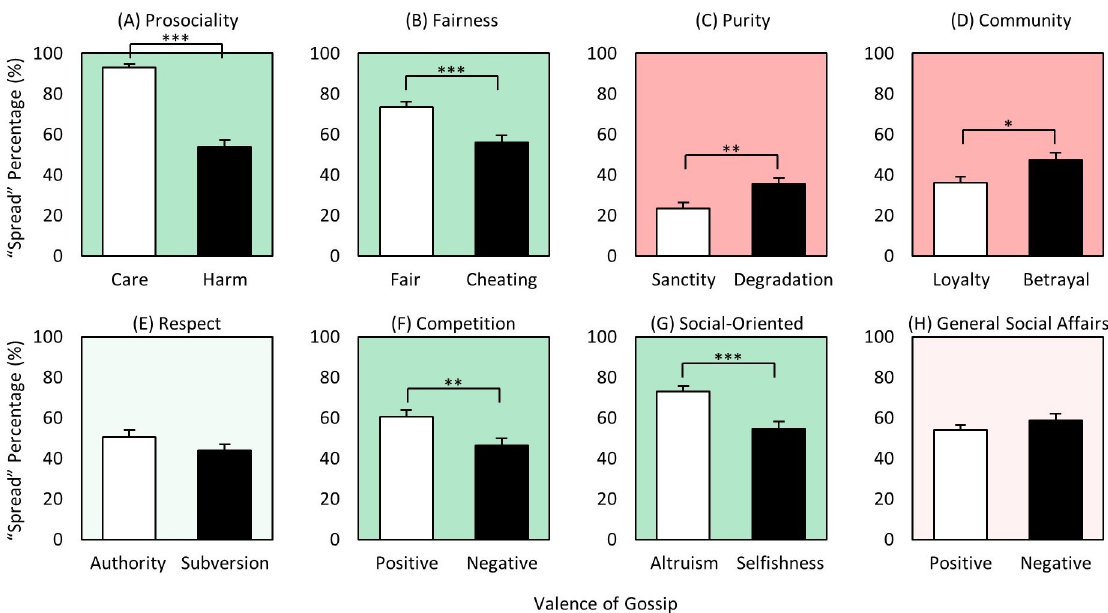
Fig 10. Mean gossip spread rates about ingroup targets for positive versus negative events. The graphs with green shade ((A), (B), (F) & (G)) are those with higher positive spreading rates than negative spreading rates. The graphs with red shade ((C) & (D)) are those with the opposite pattern. The graphs with pale green (E) and pale red (H) are not statistically significant yet show the trends of the graphs with the corresponding colors. � p < 0.05, �� p < 0.01, ��� p < 0.001.